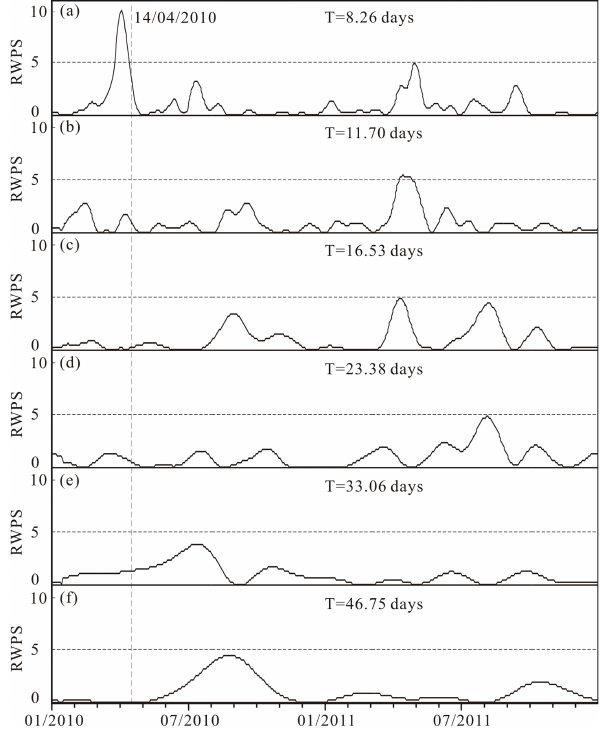
Fig. 4. RWPS of one pixel (5km × 5km resolution) was located at 31.8 ◦ N, 96.3 ◦ E from 1 January 2010 to 31 December 2011. Peri- ods of our focused bands were between 8 and 64days. If we define RWPS exceeding 5 as anomaly here, there are only two anomalies in the two years. One was in March and April 2010 with a period of 8.26days (discussed in this paper). The other was in April 2011 with a period of 11.7days. But there was no earthquake in this anomaly